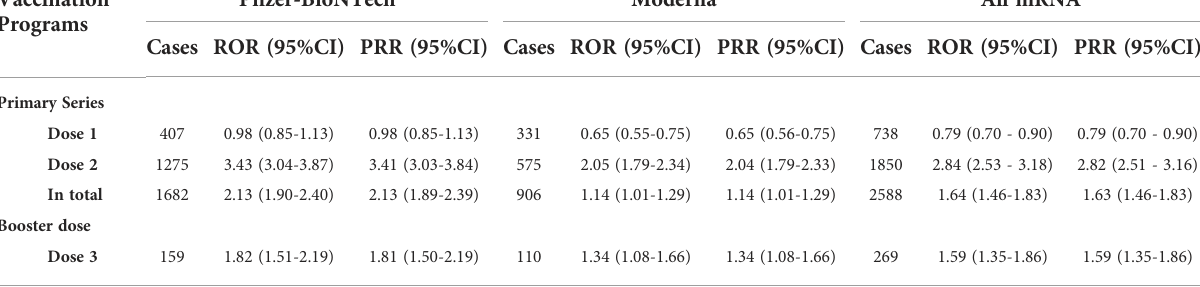
TABLE 4 Results of overall disproportionality